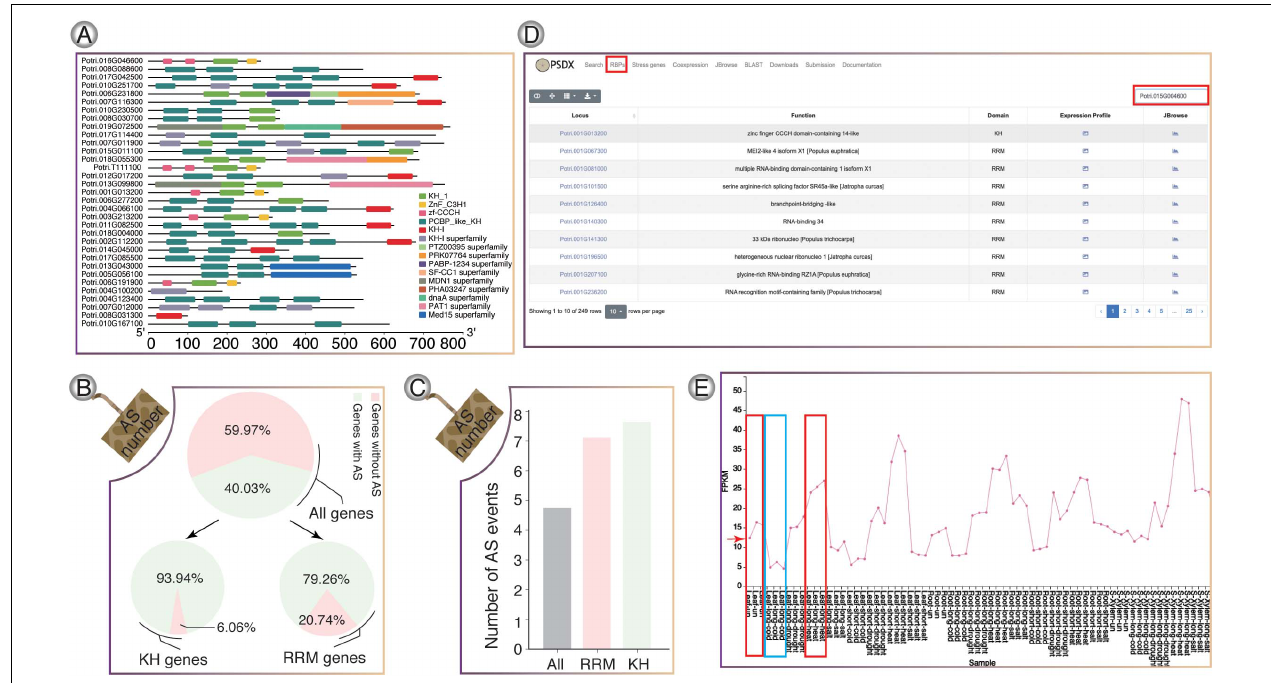
FIGURE 4 | RNA-binding protein genes in P. trichocarpa . (A) KH-domain structure diagrams. (B) Venn diagram shows the percentage of AS in all genes, KH-containing genes, and RRM-containing genes, respectively. (C) The average number of AS events for RRM and KH domain genes, respectively. (D) The module of RNA binding protein. (E) Splicing factor Potri.015G004600 ( PtrSR34A ) was selected as one case, which showed up-regulation upon heat stress (red box) and down-regulation upon cold stress (blue